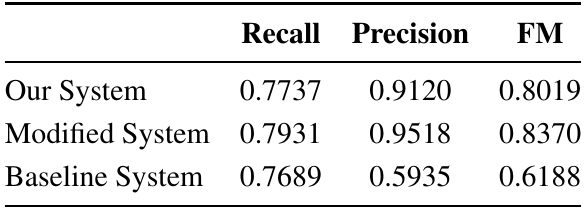
Table 3. Comparison of Clustering Results using Google News